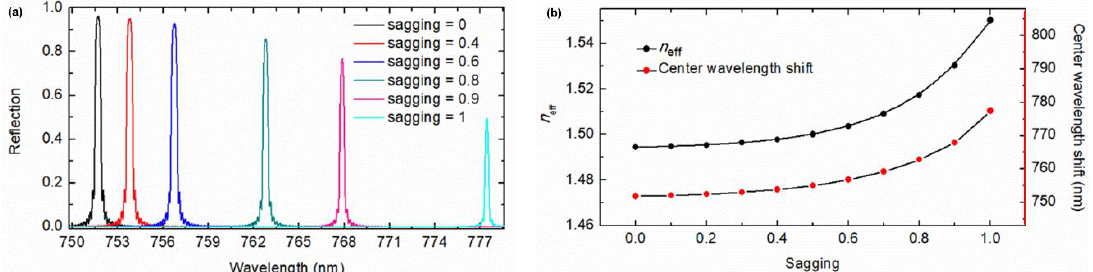
Figure 7. ( a ) Wavelength tuning of the Bragg grating; ( b ) Dependences of the tunable effective refractive index n eff and the simulated center wavelength shift dependence on sagging extent h sag / h .